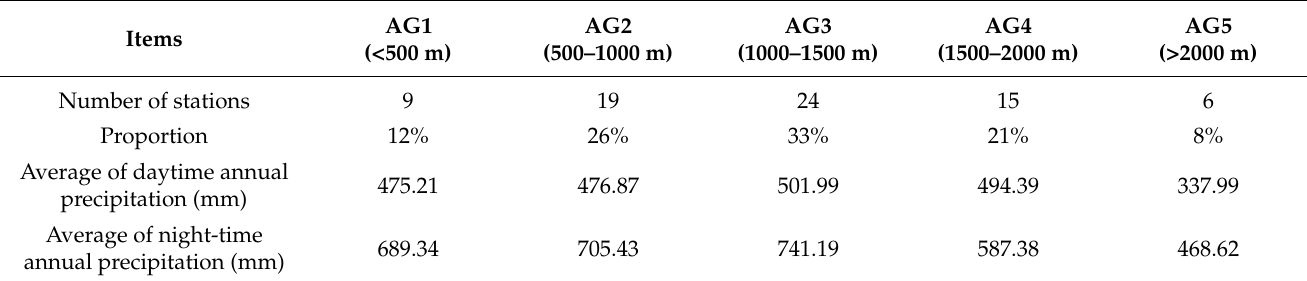
Table 3. Statistics of meteorological stations in different altitude gradients